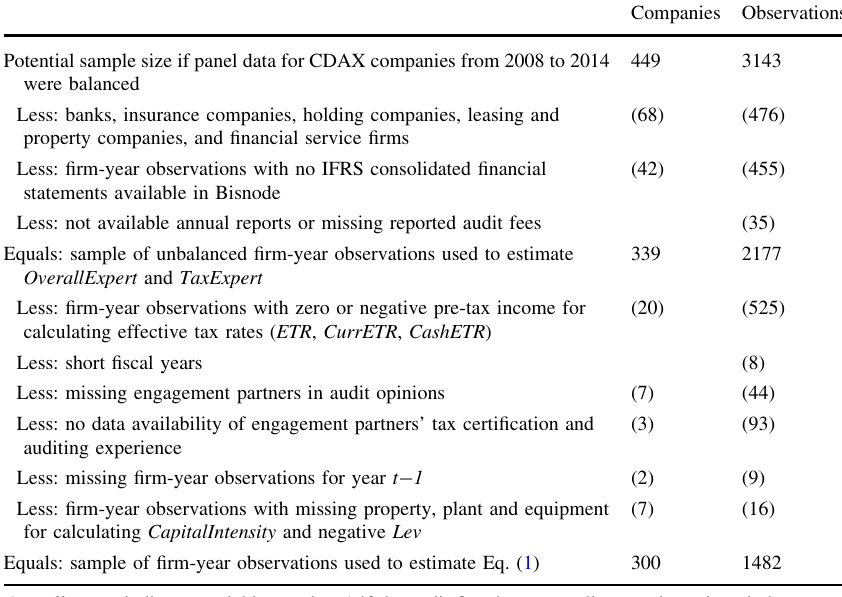
Companies Observations